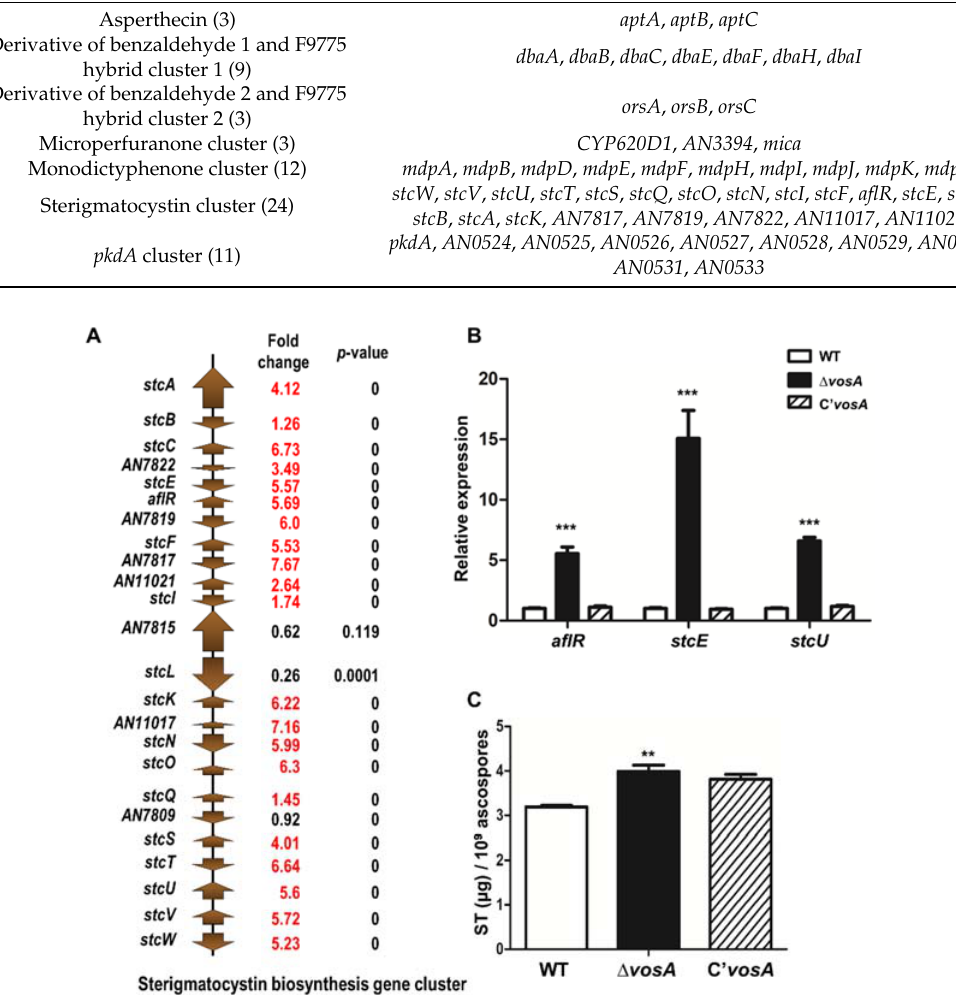
Figure 5. Sterigmatocystin production in the Δ vosA mutant ascospores. ( A ) Differentially regulated genes involved in the sterigmatocystin gene clusters in the Δ vosA ascospores. ( B ) mRNA expression of aflR , stcE , and stcU in WT, Δ vosA , and C’ vosA ascospores. ( C ) Sterigmatocystin was extracted from 10 9 ascospores of WT, Δ vosA , and C’ vosA strains. Extracted sterigmatocystin was measured by high-performance liquid chromatography (HPLC) (measured in triplicate). (WT vs. Δ vosA , ** p < 0.01, *** p < 0.001). Table 2. Secondary metabolite clusters affected by VosA in ascospores.